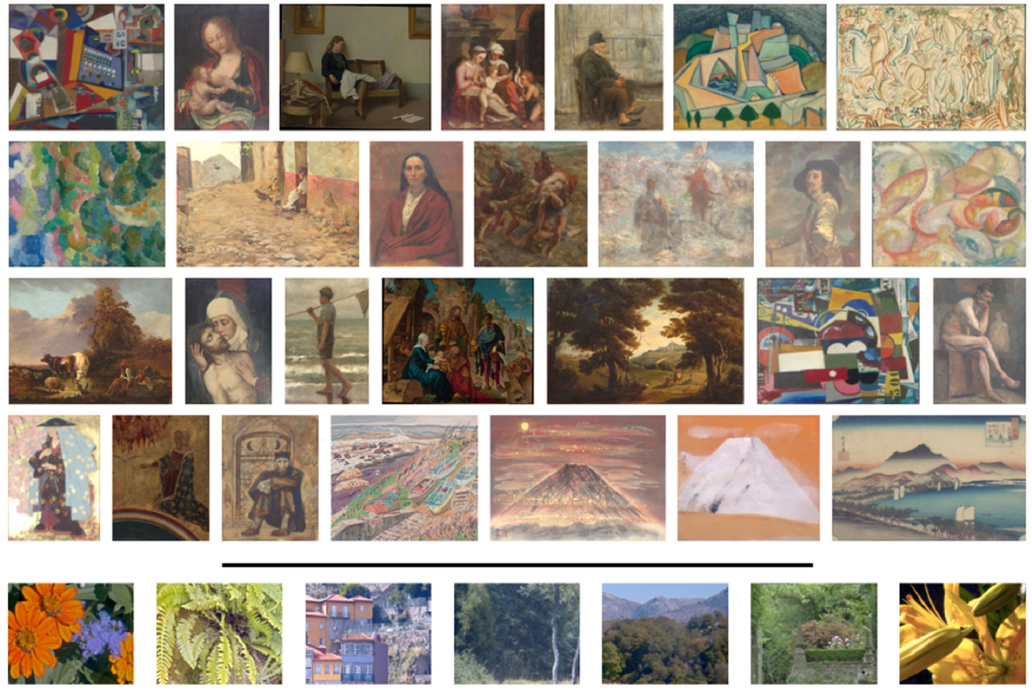
Figure 2. Representative images of the 89 paintings (above line) and 50 natural scenes (bellow line) analyzed in this work.